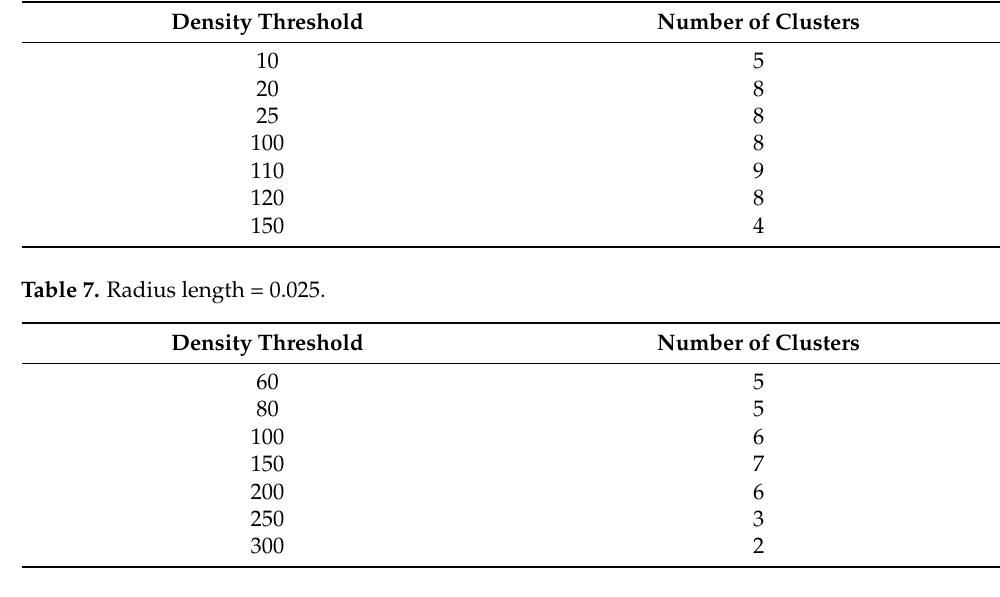
Table 6. Radius length = 0.01.